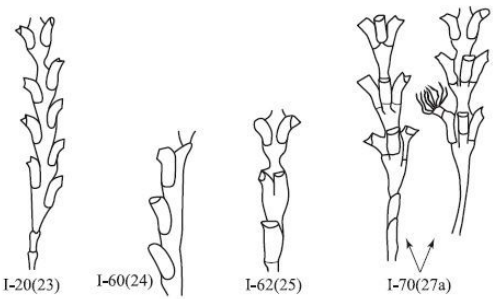
Figure 5. Shoot morphovariations of D. pumila , resembling the shoot structure in other genera of the family Sertulariidae.